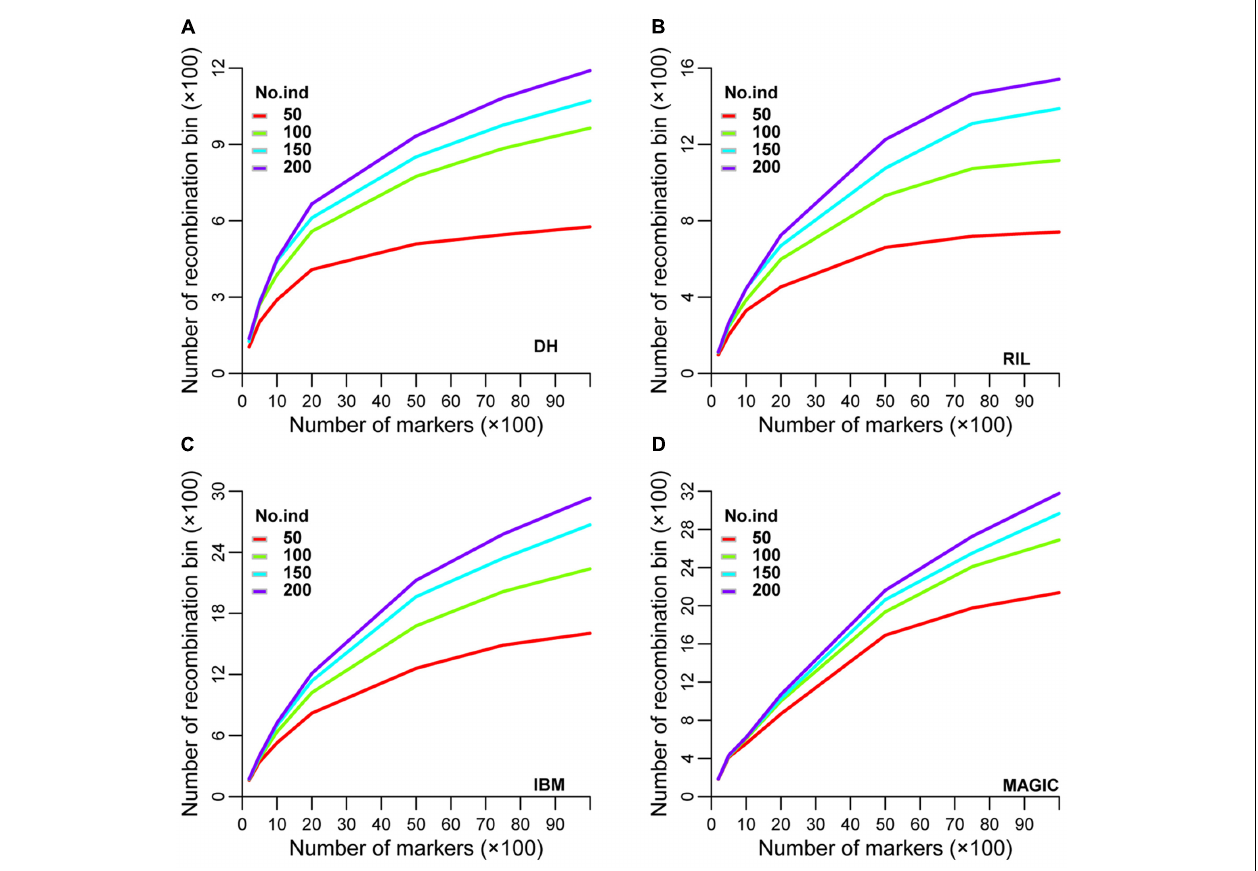
FIGURE 3 | Simulation of recombination bin number in four types of population. Variation of recombination bin number among different densities of markers and numbers of lines in (A) DH, (B) RIL, (C) IBM, and (D) MAGIC population(s). DH, double haploid; RIL, recombination inbred lines; IBM, intermated B73xMo17; MAGIC, multi-parent advanced generation